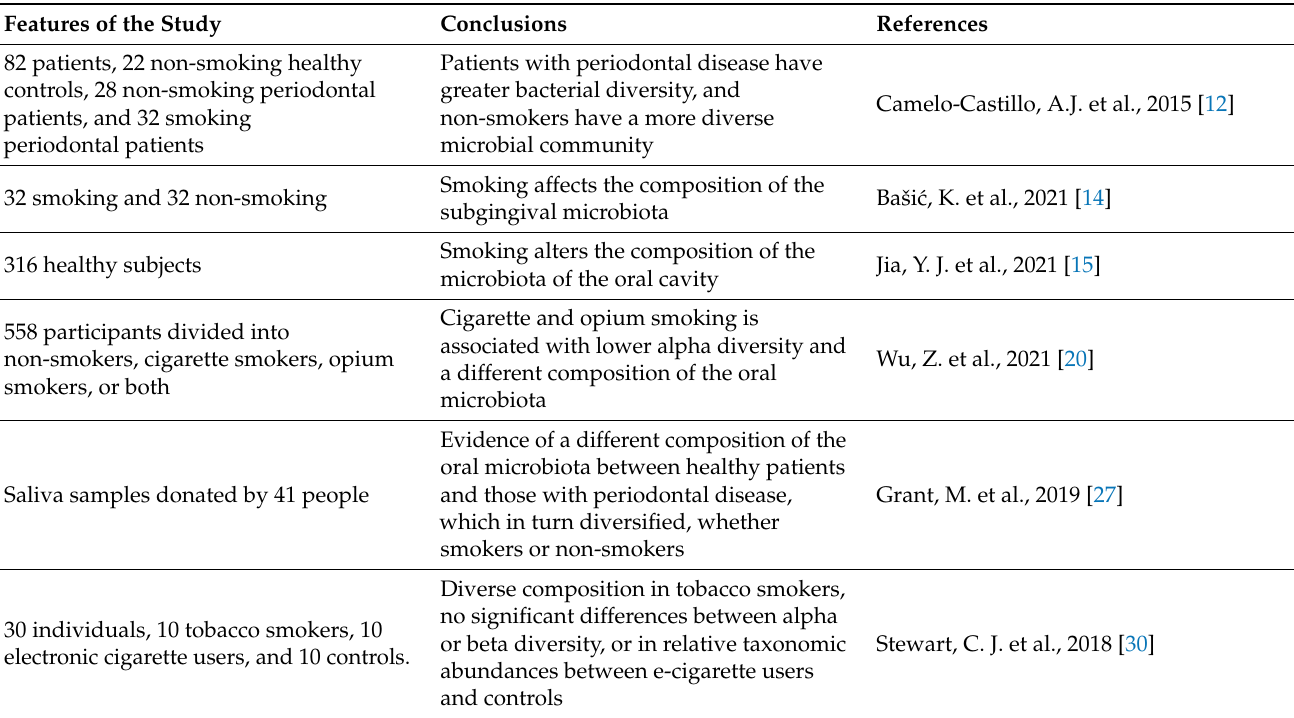
Table 3. Main studies conducted on the relationship between smoking and the oral cavity microbiota